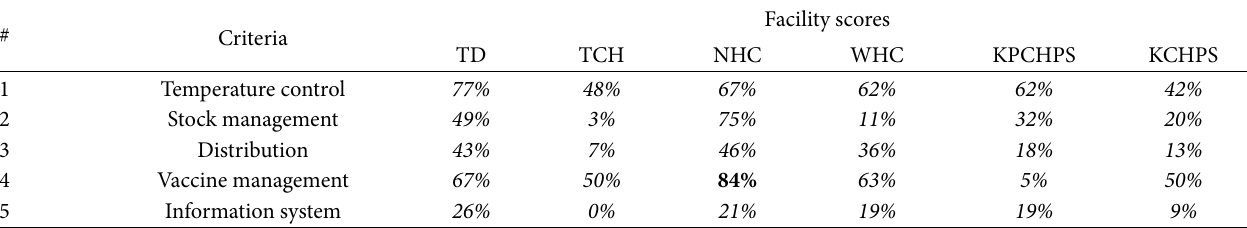
Table 2: Summary of consolidated EVM criteria scores by facility, Tolon